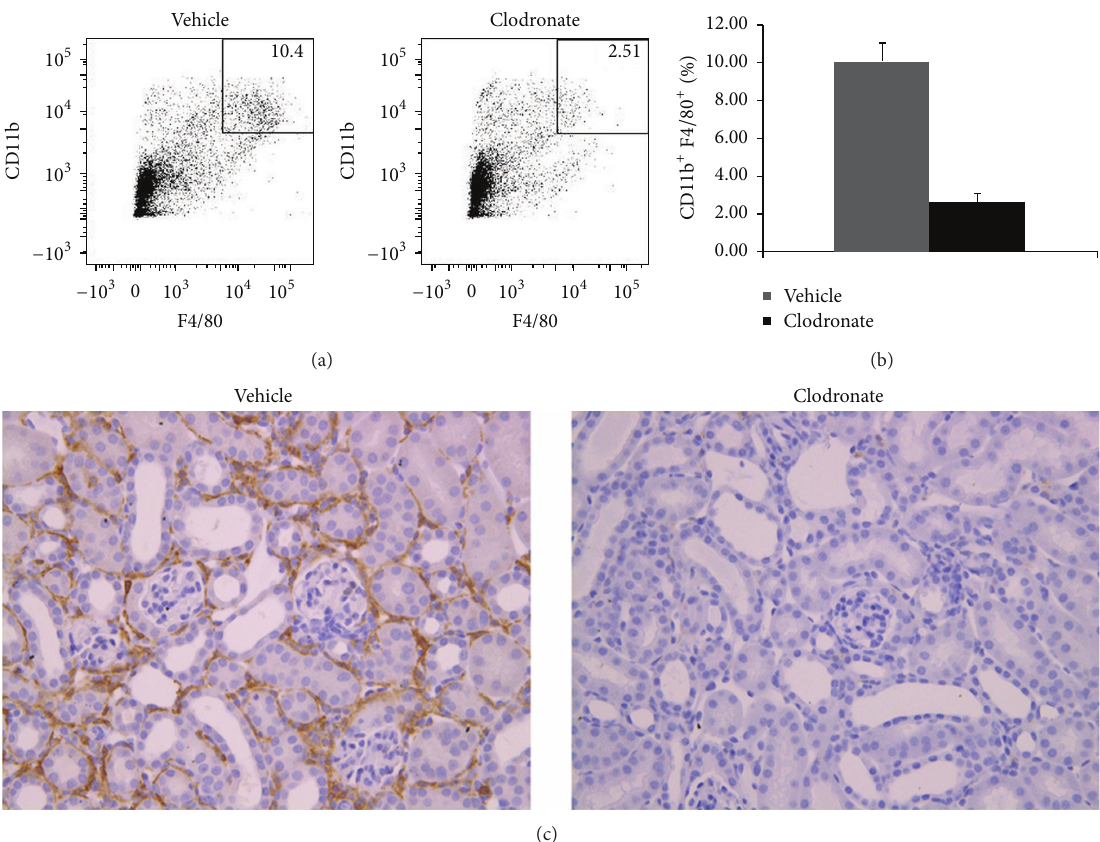
Figure 3: CD11b + and F4/80 + cells in kidneys of clodronate-treated or control mice after 6 days of UUO (i.e., day 0 of the rUUO protocol). Representative flow cytometry is shown for CD11b + and F4/80 + (a) with data from all kidneys shown graphically (b). Representative immunohistochemical staining for F4/80 is also shown (c). 𝑁 = 5 -6 per